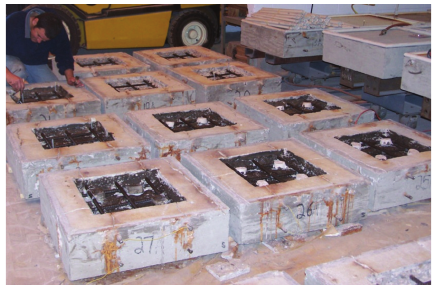
Figure 6: Patch repairs of laboratory specimens.